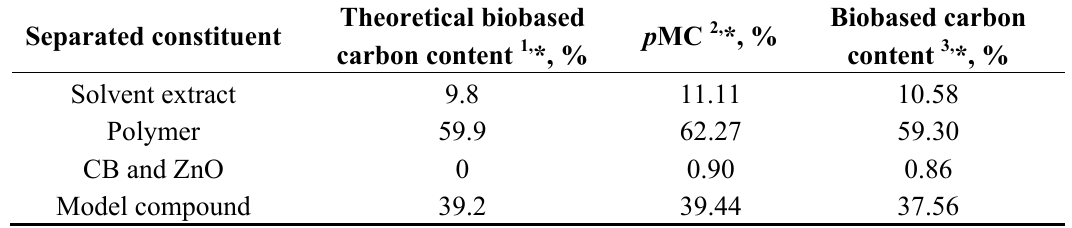
Table 9. p MC determined from 14 C concentration measured by AMS and biobased carbon content calculated from p MC for separated constituents and model